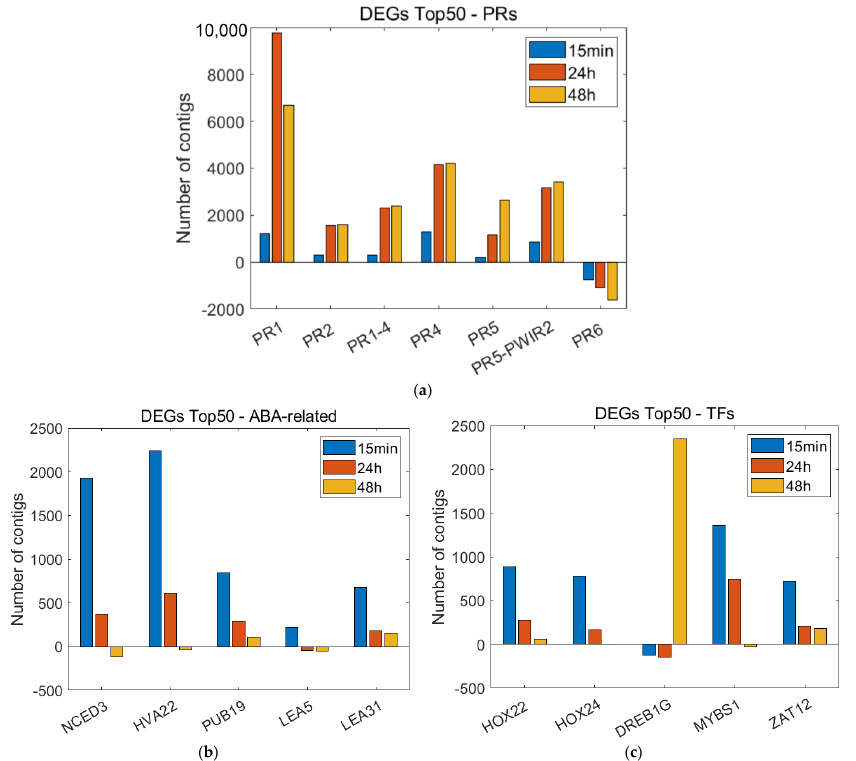
Figure 5. The determination of the top 50 differentially expressed genes (DEGs) in silico is represented in three sampling times. The numerical analysis of DEGs in a pairwise comparison of two times was examined using OmixBox.BioBam based on the RSEM and edgeR programs. These quantitative statistical methods to evaluate the significance of individual genes were implemented to examine the changes in the expression levels of ( a ) PR genes (control vs. 48 h); ( b ) ABA pathway-related genes (control vs. 15 min); and ( c ) TF genes (control vs. 15